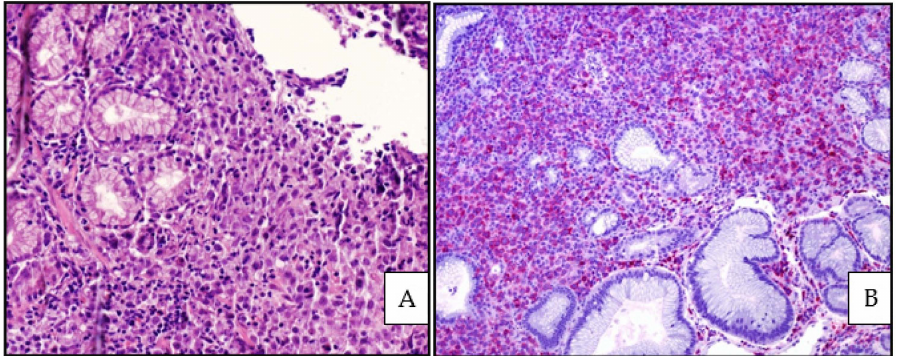
Figure 1. ( A ) EBV-positive DLBCL, NOS: medium power view showing a polymorphic infiltrate within the gastric mucosa (Hematoxylin and eosin, magnification 400 × ; original image from Prof S.A. ( B ) EBV-positive DLBCL, NOS: CD79alpha positivity highlighting the B-cell phenotype of the lymphoid infiltrate (immunostaining, magnification 200 × ; original image from Prof S.A.).